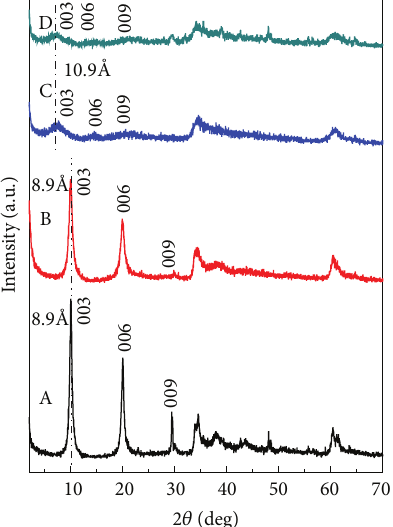
Figure 1: Powder X-ray diffraction patterns for the (A) Zn/Al-LDH, (B) Tween-LDH, (C) dopa-LDH nanocomposite, and (D) Tween- dopa-LDH